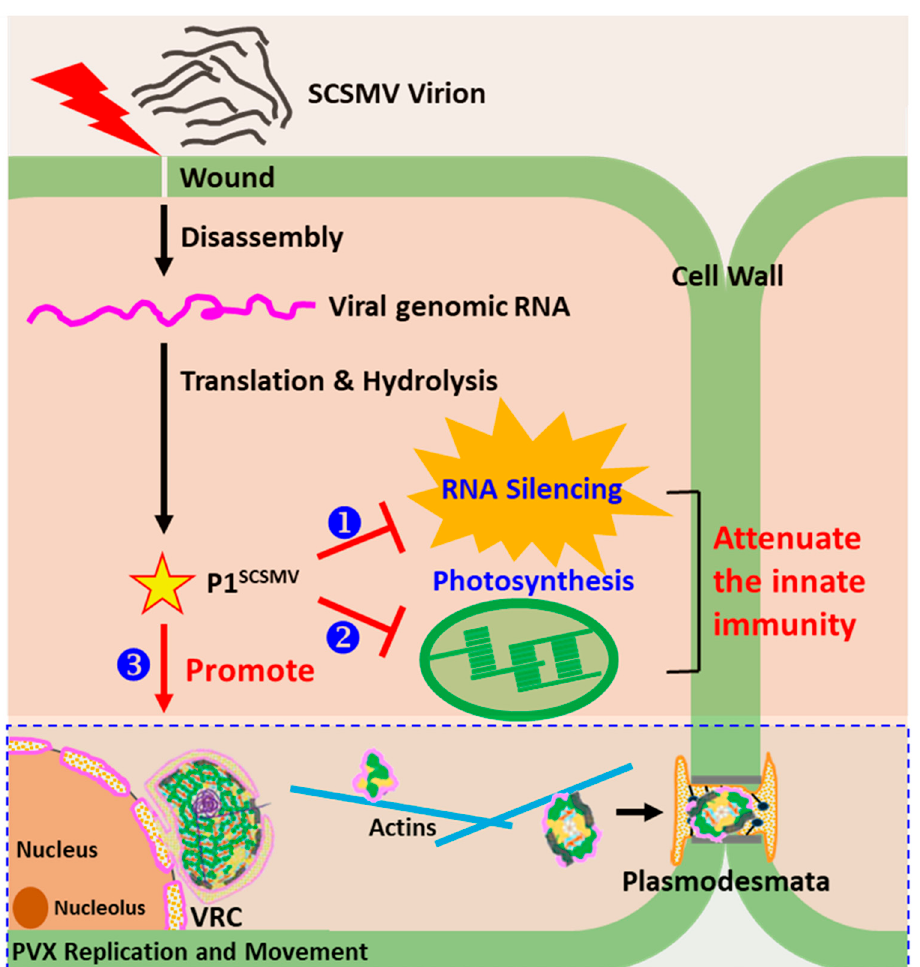
Figure 9. Schematic representation of the possible mechanisms of the disease-enhancing role of P1 SCSMV for PVX in plant cells. Under natural conditions, either the direct touching and rubbing of leaves or harvesting of sugarcane by cutting leads to SCSMV entry into the cell through a